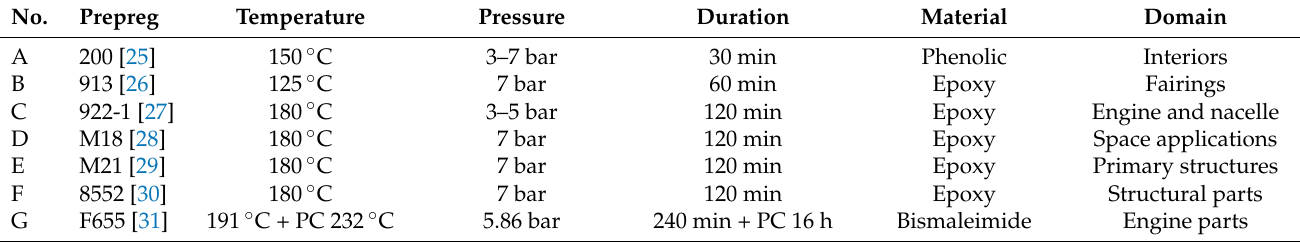
Table 2. Curing conditions for a selection of HEXCEL HexPly ® prepregs recommended for aerospace application (component thickness <